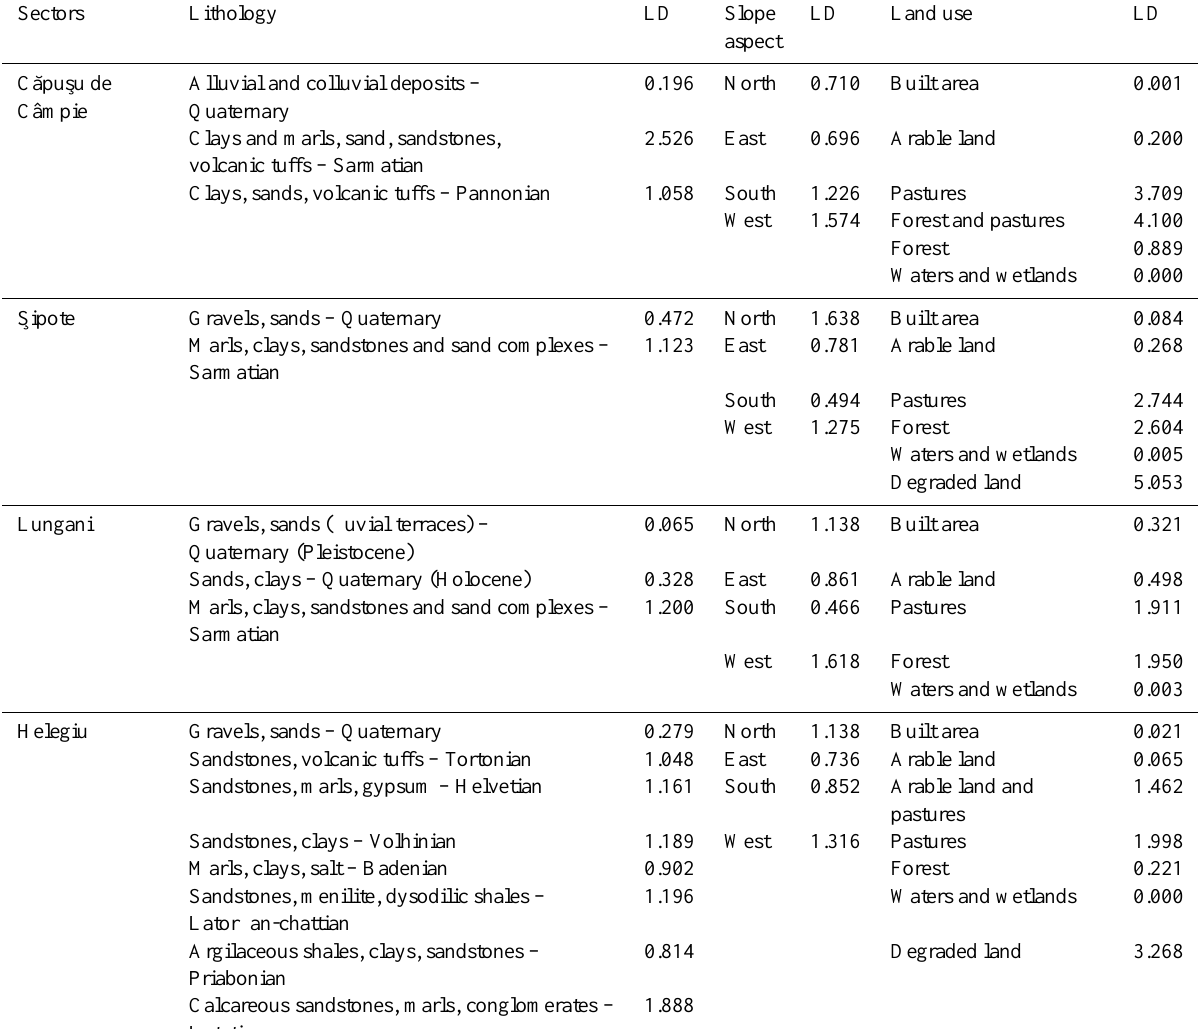
Table 3. Landslide density (LD) for lithology, slope aspect and land use classes.